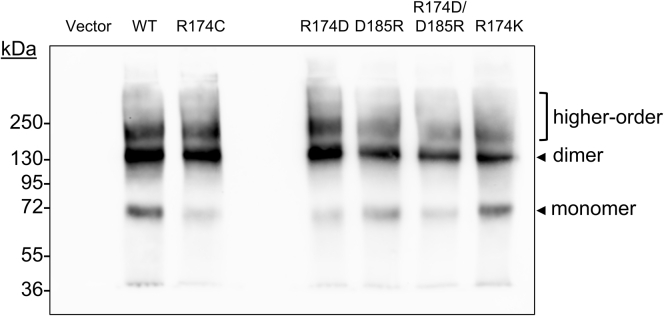
R174C-SR-BI and “salt bridge” mutants form dimers and higher order oligomers. COS-7 cells transiently expressing WT-SR-BI or mutant SR-BI were sonicated, and proteins (10 μg) were separated in the presence of 5% perfluorooctanoic acid under nonreducing conditions for subsequent immunoblot analysis to assess the oligomerization profiles of SR-BI. A representative immunoblot is shown for three independent transfections (n = 3). SR-BI, scavenger receptor class B type I.